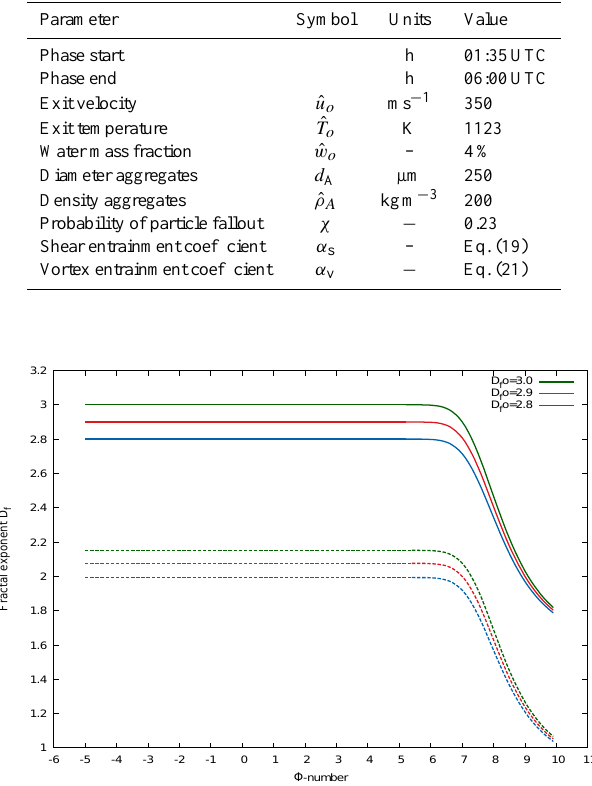
Figure 5. (a) : wind and temperature atmospheric profiles during 4 April 1982 at 00:00UTC from sounding. (b) : FPLUME bulk veloc- ity ˆ u and radius r with height z . The black solid line indicates the height of the NBL determined by the